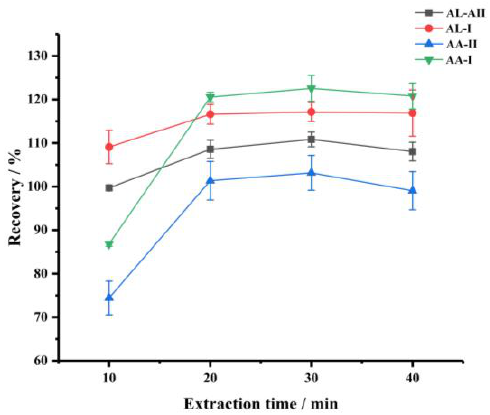
Figure 4. The effect of extraction time (extraction solvent, methanol; volume of extraction solvent, 15 mL).